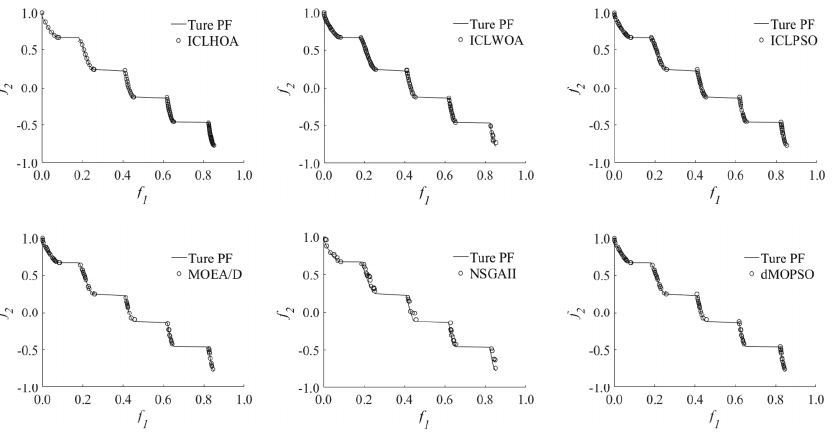
Figure 11. ZDT3 PF of each optimization algorithm.